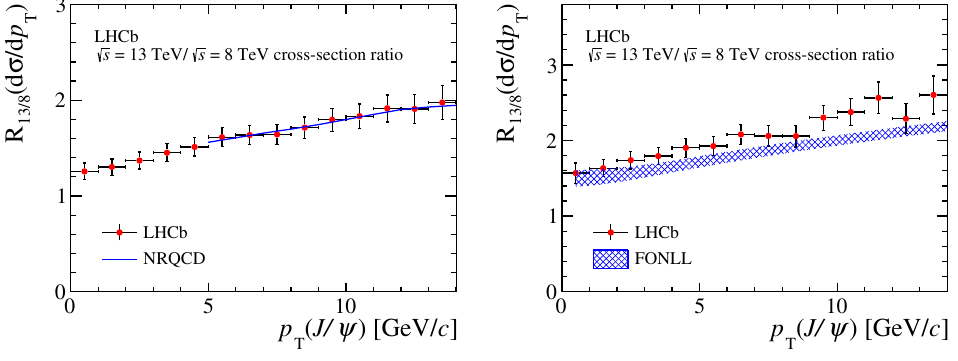
p p s = 13 TeV and s =